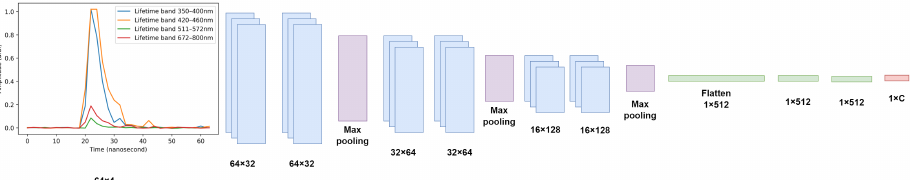
Figure 4. The fluorescence spectrum feature extractor architecture, with C being the number of classes in each dataset.